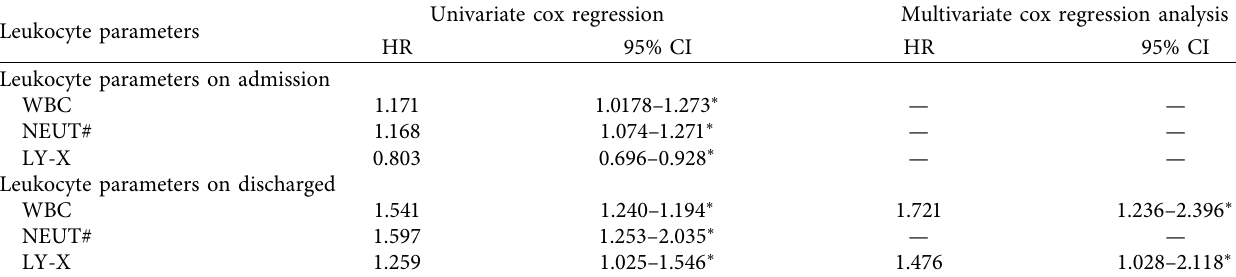
Table 7: Cox regression analysis of leukocyte parameters on clinical outcome of sepsis patients.